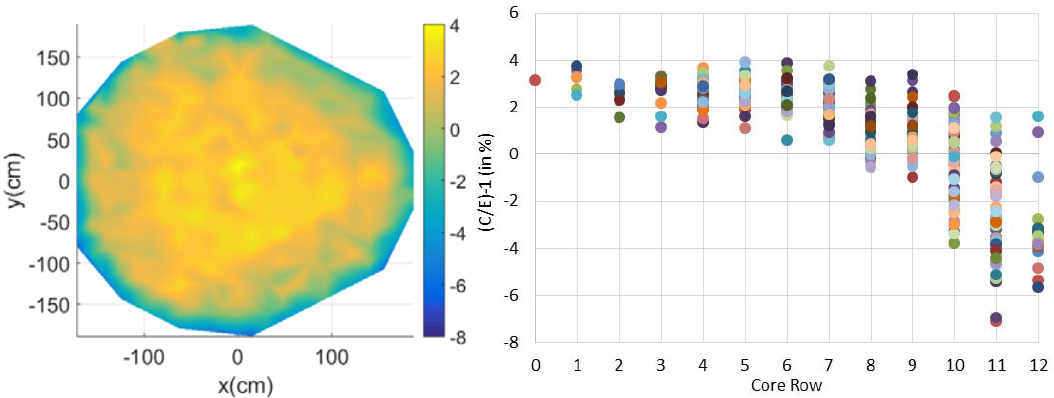
Figure 3. Core power distribution discrepancies for the whole core (left) and per core rows